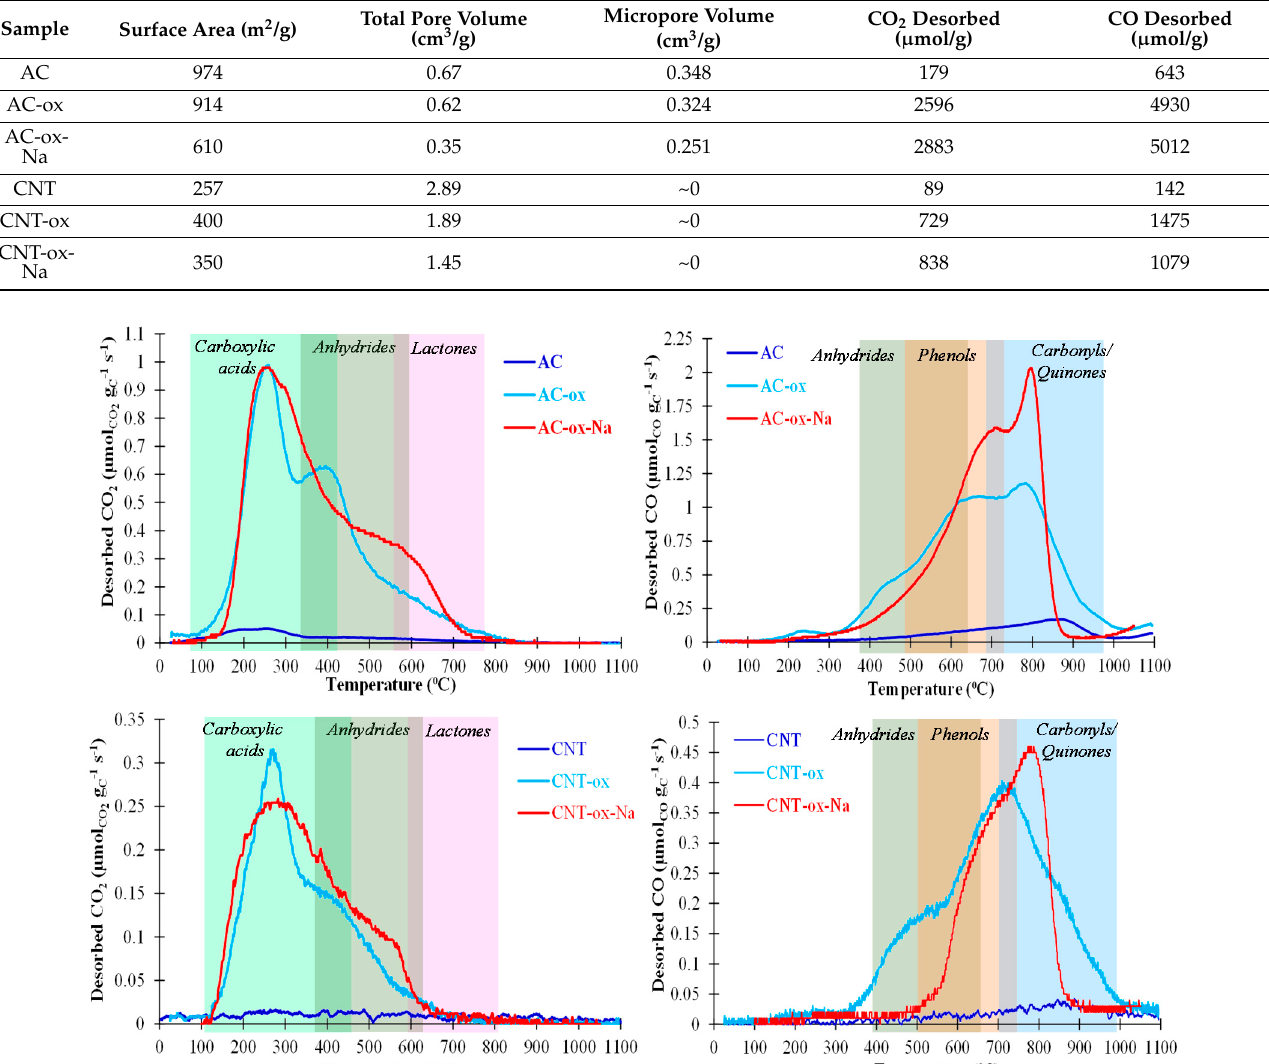
Table 2. Characterization of carbon supports: surface area, total pore volume and micropore volume obtained by adsorption of N 2 at − 196 ◦ C and amounts of CO and CO 2 desorbed, determined by TPD (adapted from [13]). Sample